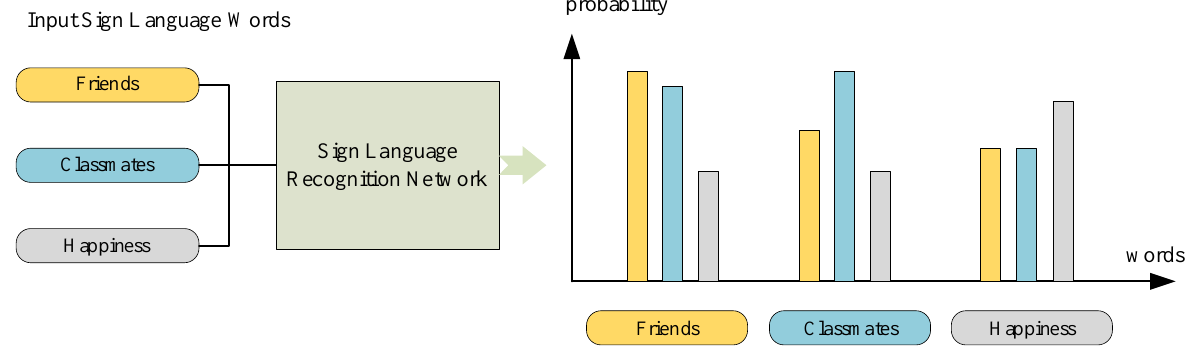
Figure 12. The output of each sample is a probability